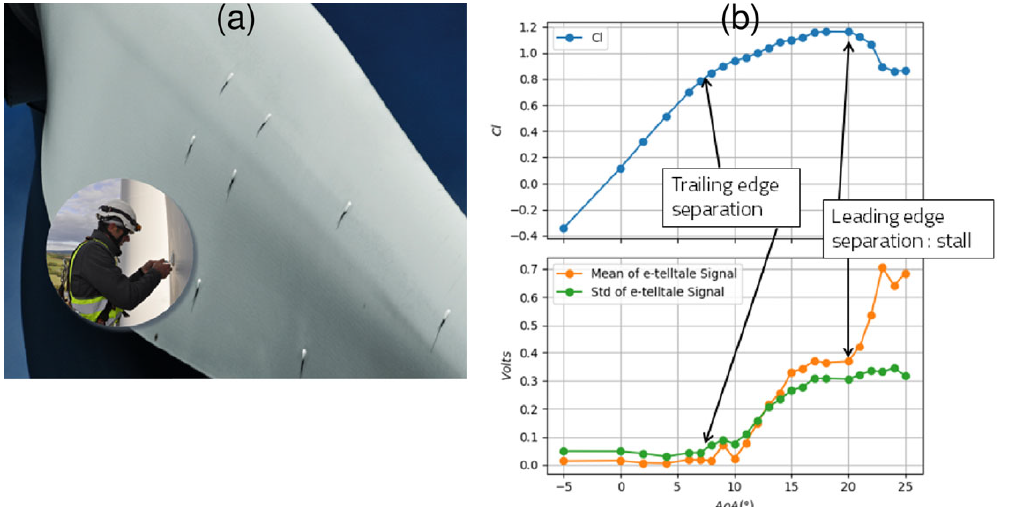
Figure 1. Previous studies. (a) Robustness and practical mounting issues solved on EDF Renewables wind turbines. (b) Ability of full-scale e-TellTale sensors located at the blade trailing edge to detect static flow separations at high chord Reynolds numbers (10 6 ) from wind tunnel tests: increase in the e-TellTale signal after stall angle, at 20 ◦ .